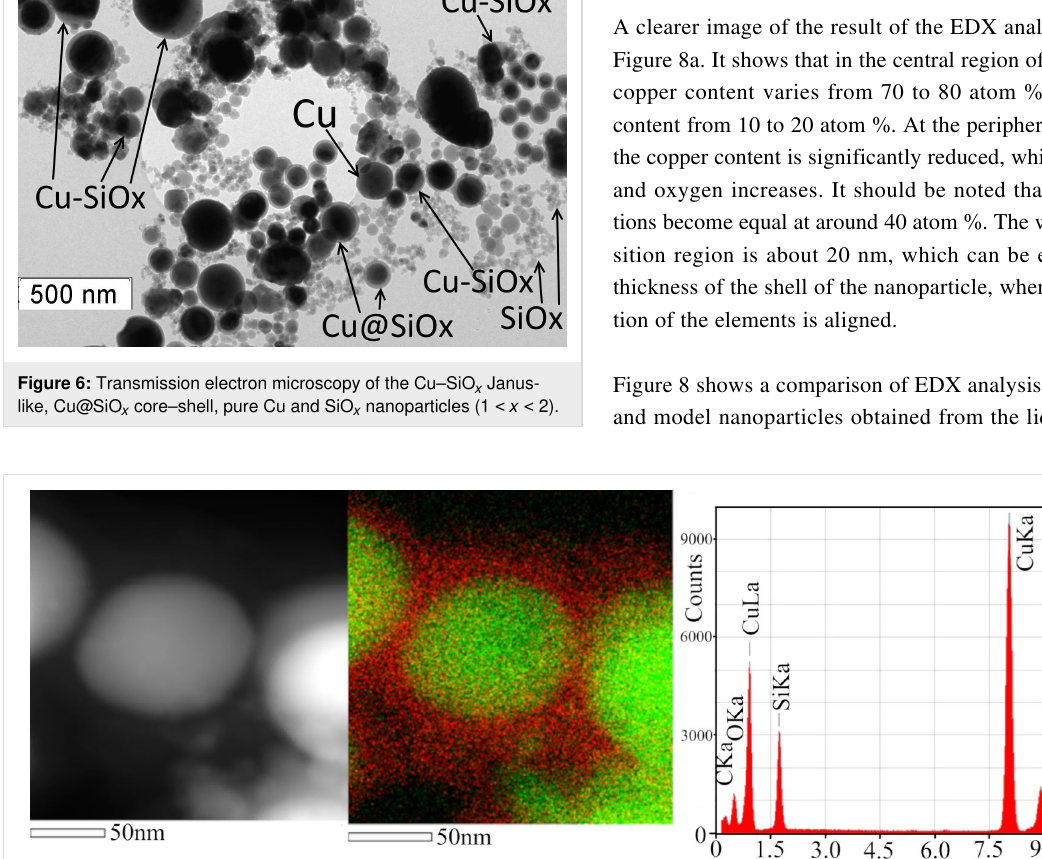
located at large distance from the central copper part. The (4.63 eV) than copper (3.54